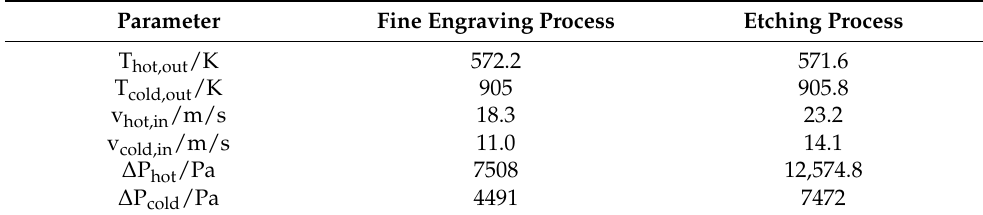
Table 13. Results for single-channel heat transfer calculations by Yang and Huo